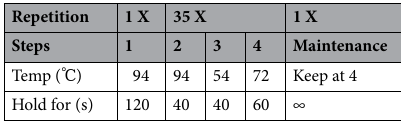
Table 4. Steps of the standard PCR devices.